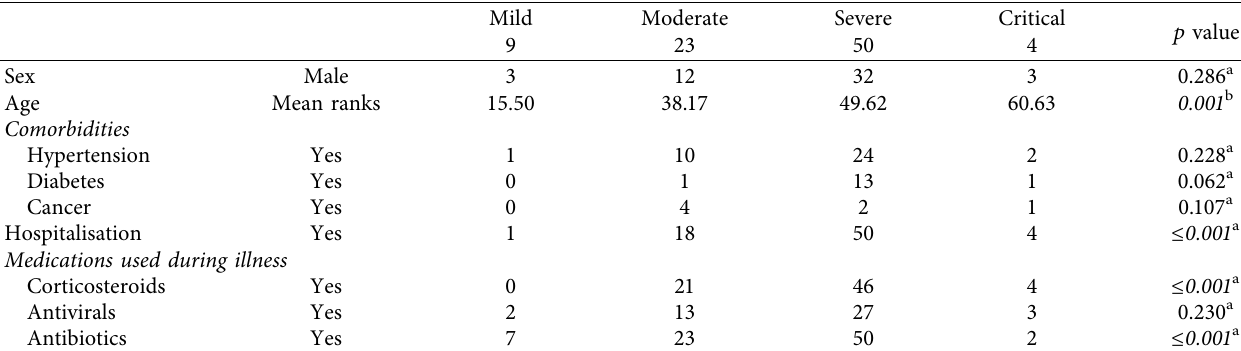
Table 2: Distribution of demographic and clinical parameters across diseases severity groups.